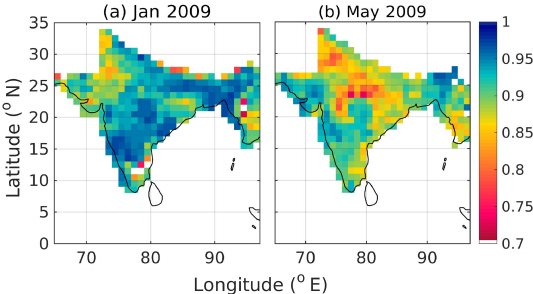
Figure 10. Spatial variation of monthly mean columnar SSA esti- mated using merged AOD and AAODs for January 2009 (a) and May 2009 (b) .